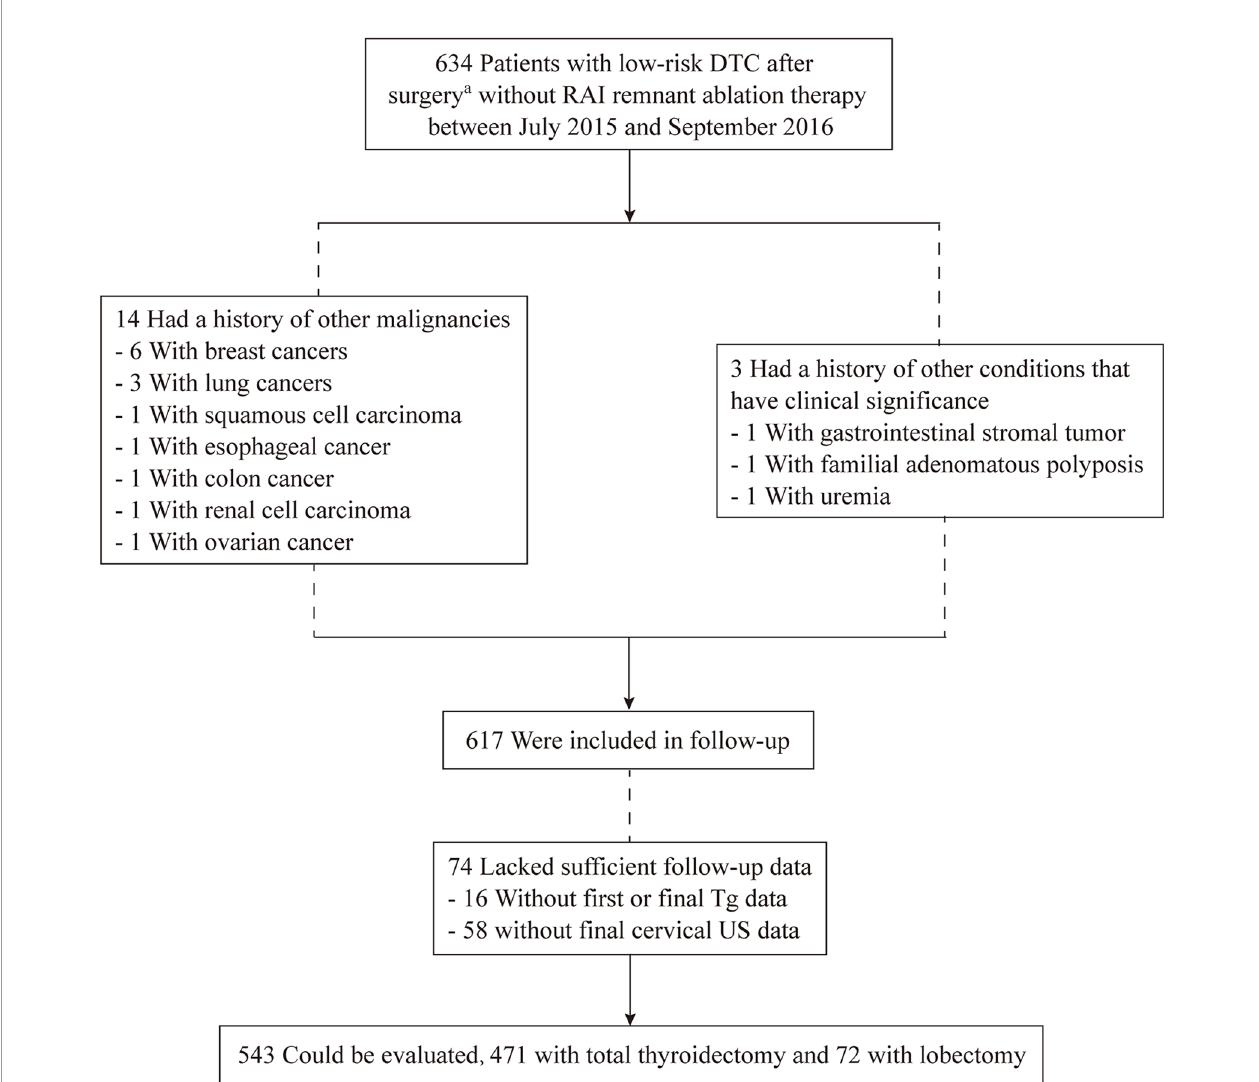
FIGURE 1 | Flow chart of inclusion-exclusion of patients with low-risk differentiated thyroid cancer without radioiodine ablation at the study. a Patients underwent lobectomy + isthmusectomy + ipsilateral central neck dissection or total thyroidectomy +/- central/lateral neck